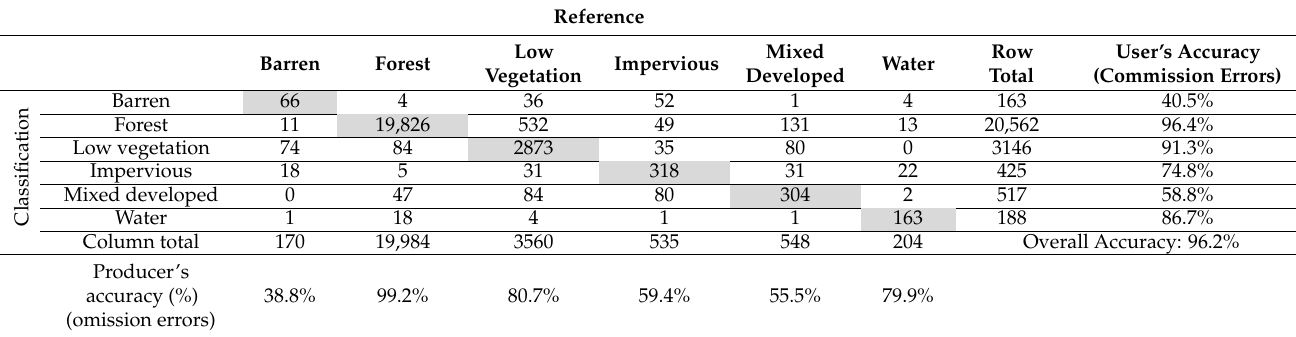
Table 6. The error matrix for the classification of 2016. Values in the cells represent the number of objects, while accuracies are reported with the percentage of land